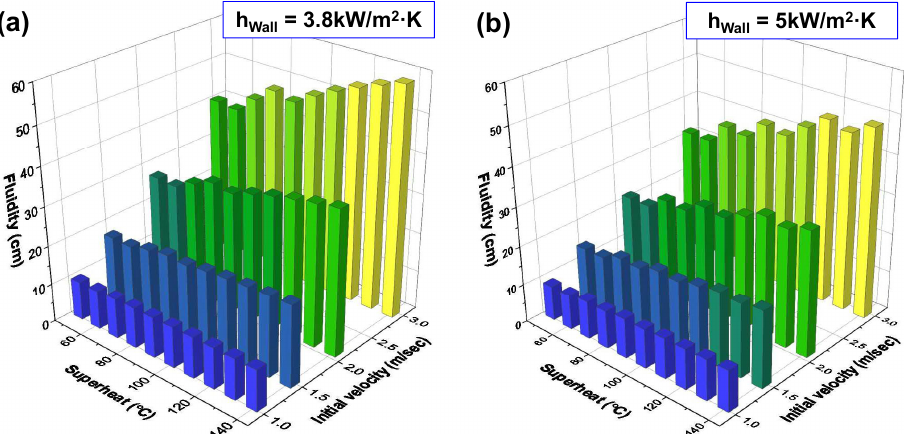
Figure 10. Prediction of the fluidity of the A356 melts at arbitrary superheat and initial velocity conditions with different heat transfer coefficients: ( a ) h = 3.8 kW/m 2 · K, ( b ) h = 5 kW/m 2 ·